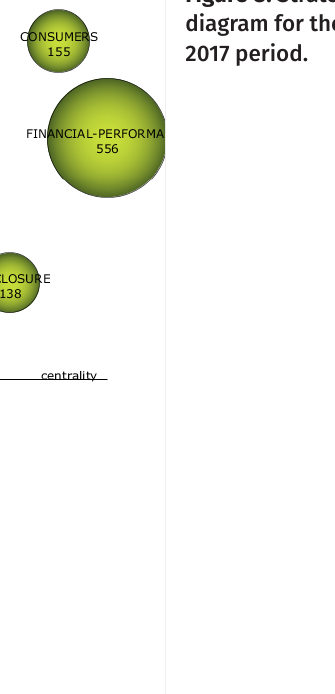
Figure 8. Strategic diagram for the 2015– 2017